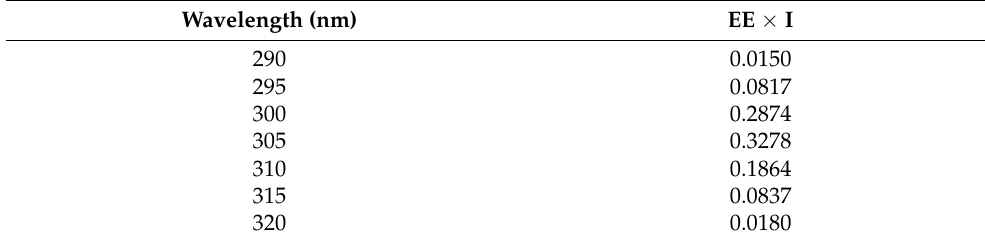
Table 6. E ( λ ) and I ( λ ) values used for SPF